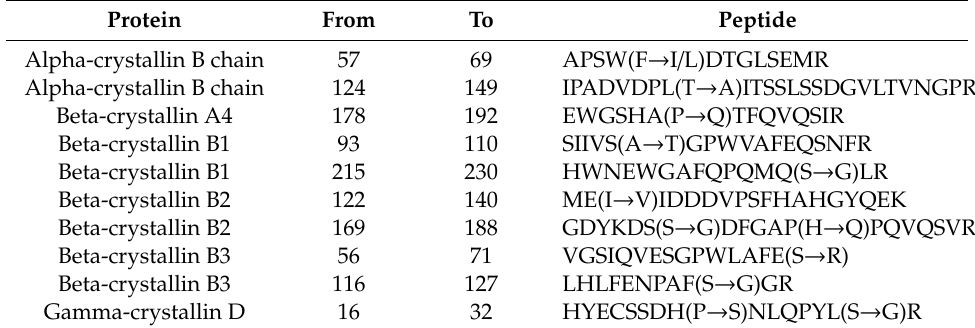
Table 1. The list of novel mutations from nuclear cataract human lens samples. Protein